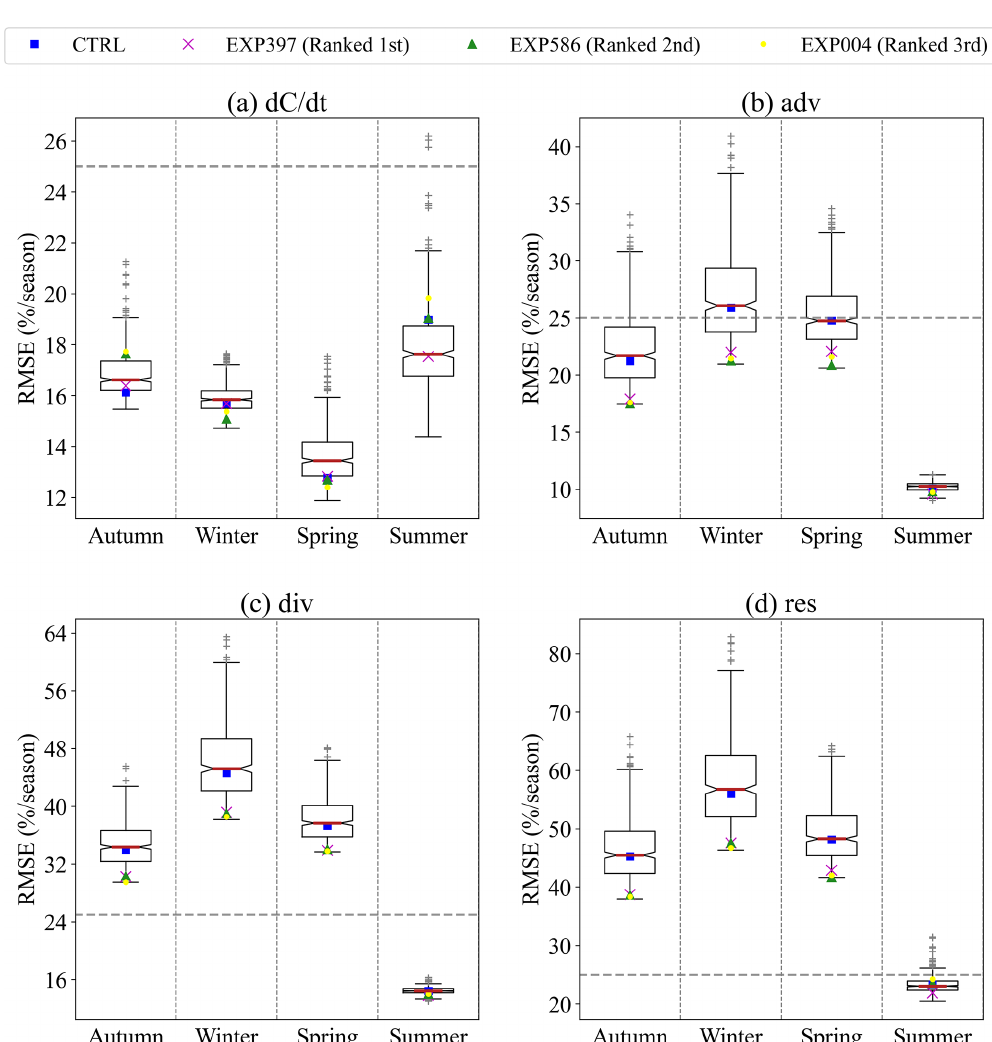
Figure 7. Boxplots of RMSE for each component of the simulated and observed SIC budget. Boxes extend from the first quartile (top border) to the third quartile (bottom border). The red line represents the median of all 449 model results. The CTRL experiment and three best-performing experiments are also flagged. The whiskers extend outwards from the box to 1.5 times the inter-quartile range, with a few flier points beyond the whiskers. The 25% horizontal dashed lines are marked as